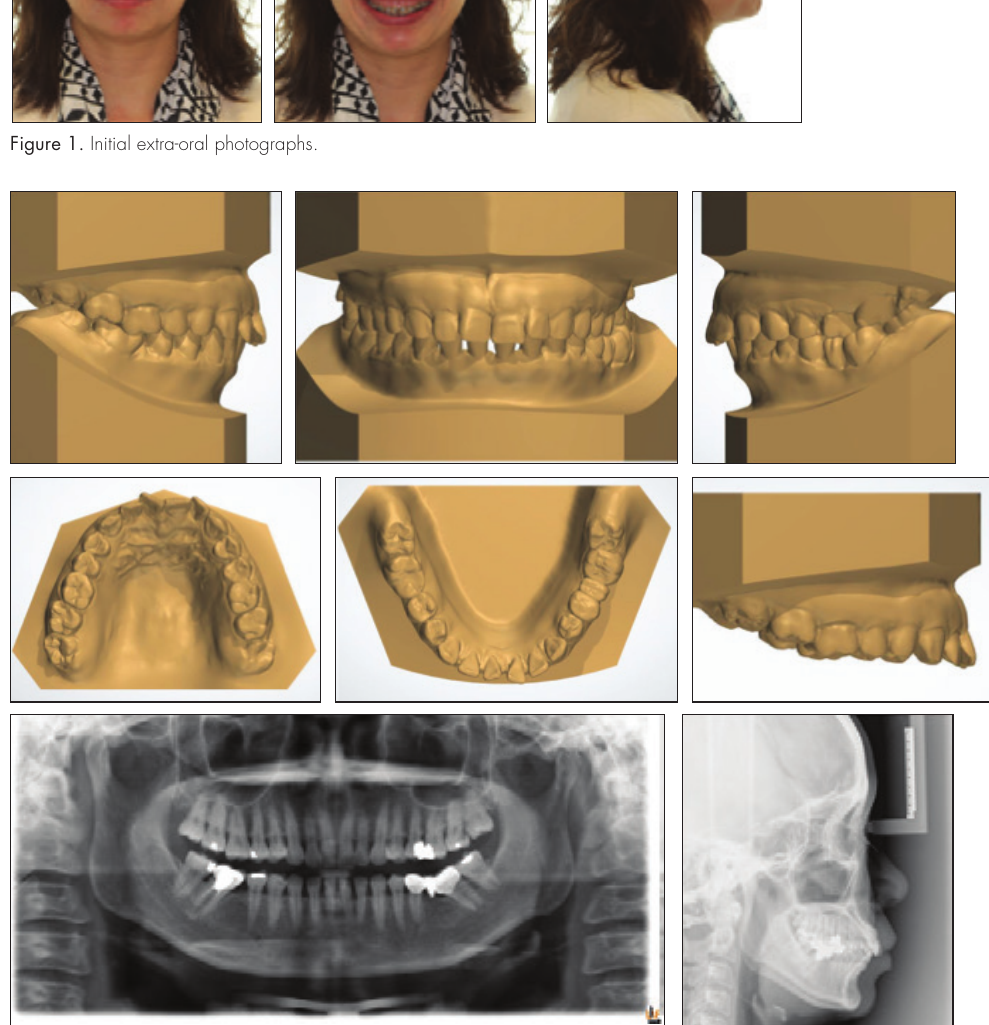
Figure 2. Pretreatment dental cast, lateral cephalometric and panoramic radiographs (taken from after the original fixed appliance were removed).